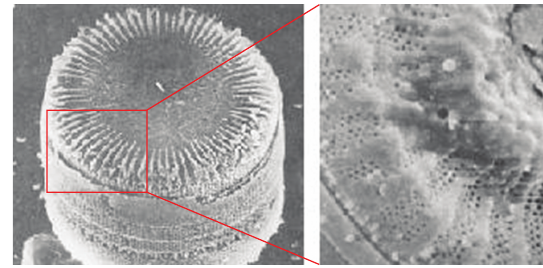
Figure 2: The typical shape of diatomite particle. The right panel shows a detailed structure of the particle. It clearly shows that there are lot of small holes in the particle, which make the particle with hydrophilic